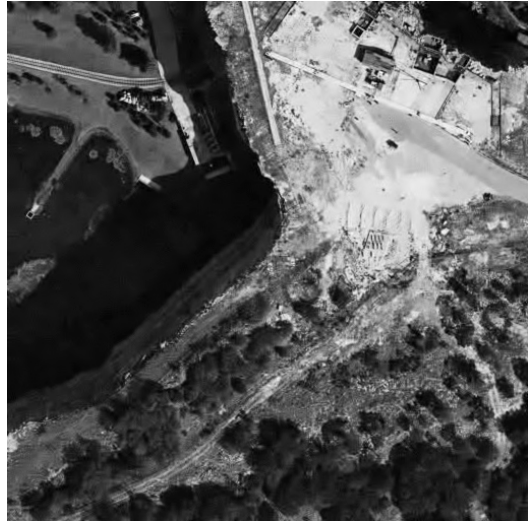
Figure 7. Output image for the 2D DCT-based filter (PSNR out = 31.11 dB; PHVSM out = 33.70 dB).